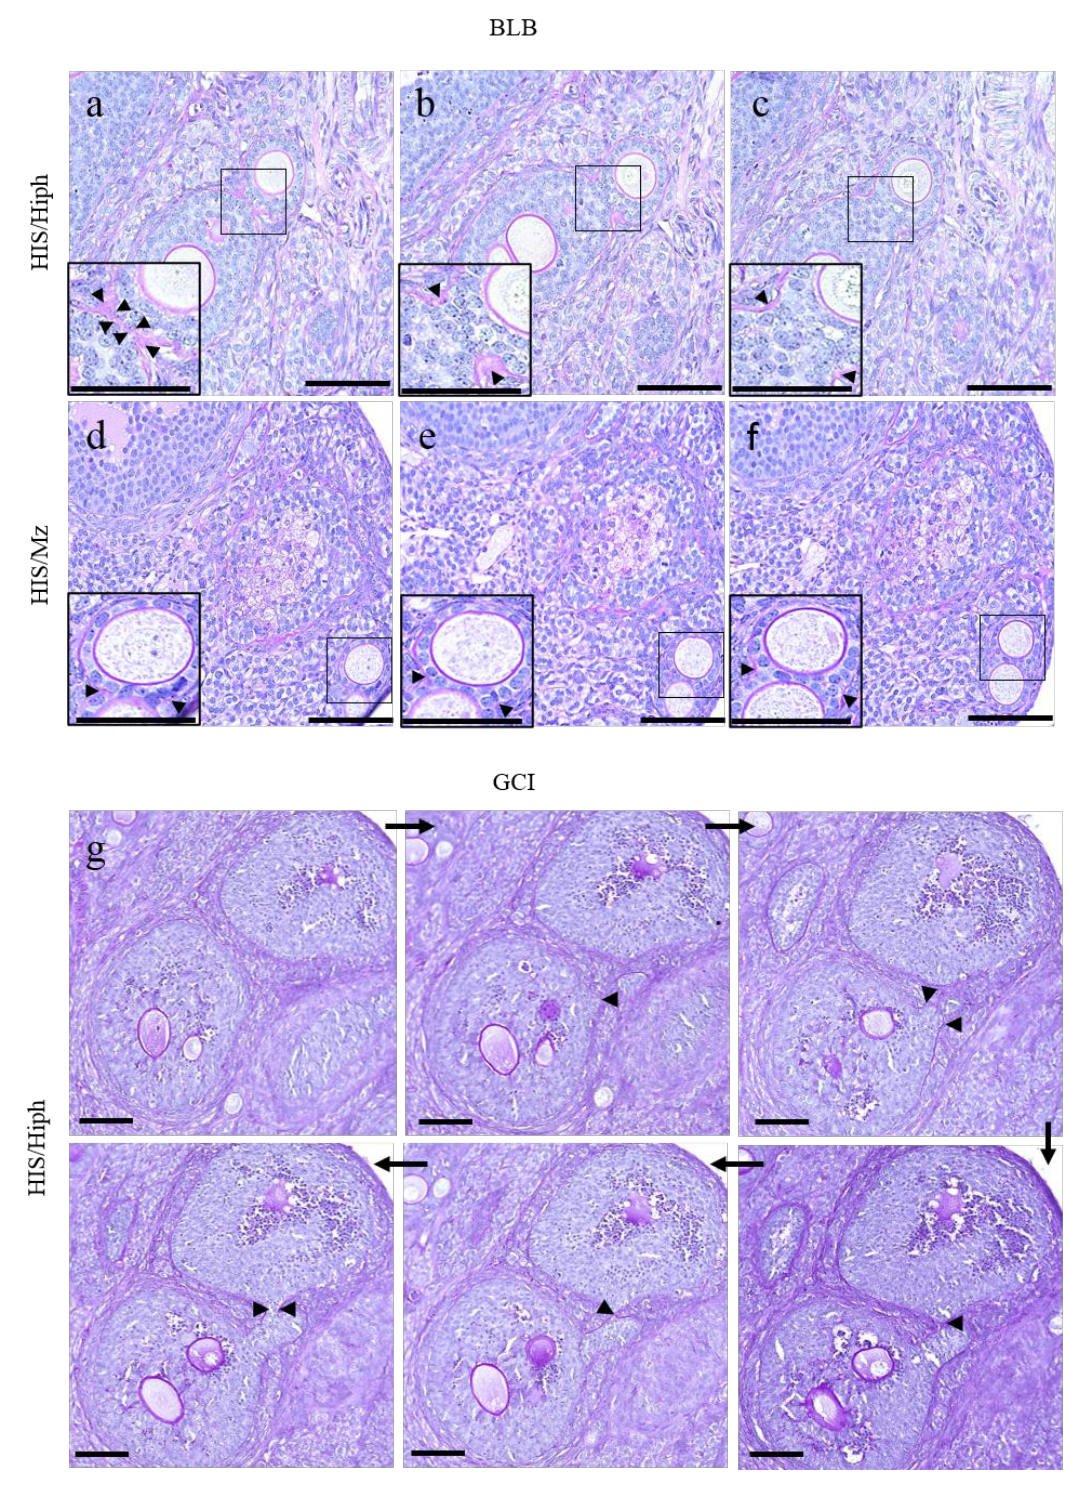
Figure 4. Unique morphological characteristics of the multi-oocyte follicles (MOFs) in the ovaries of HIS/Hiph and HIS/Mz. ( a – f ) Histological observation of basal lamina (BL) constricted-type MOFs in periodic acid Schiff (PAS)–hematoxylin-stained serial sections from the ovaries of 4-week-old HIS/Hiph ( a – c ) and HIS/Mz ( d – f ). BL constricted-type MOFs are clearly observed in HIS/Hiph ( a – c ), but they are not clear in HIS/Mz ( d – f ). ( g ) Granulosa cell (GC) bridge-type MOFs in PAS- stained serial sections in the ovary of HIS/Hiph. Arrows indicate the order to next serial sections. Arrowhead shows GC bridge regions. Scale bars = 100 µ m or 50 µ m